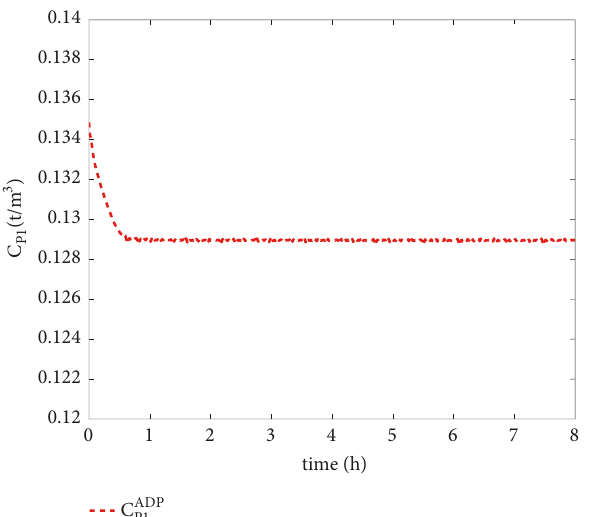
Figure 17: 𝐶 𝑃2 trajectory in Task